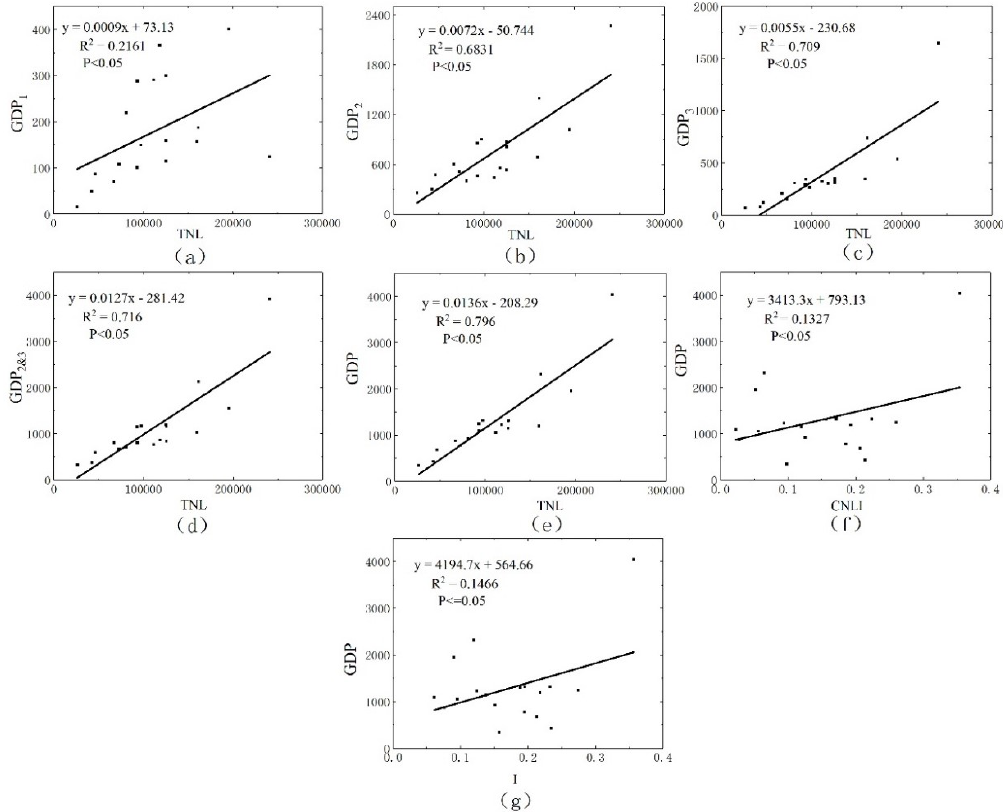
Fig.3 Light index and GDP regression analysis in